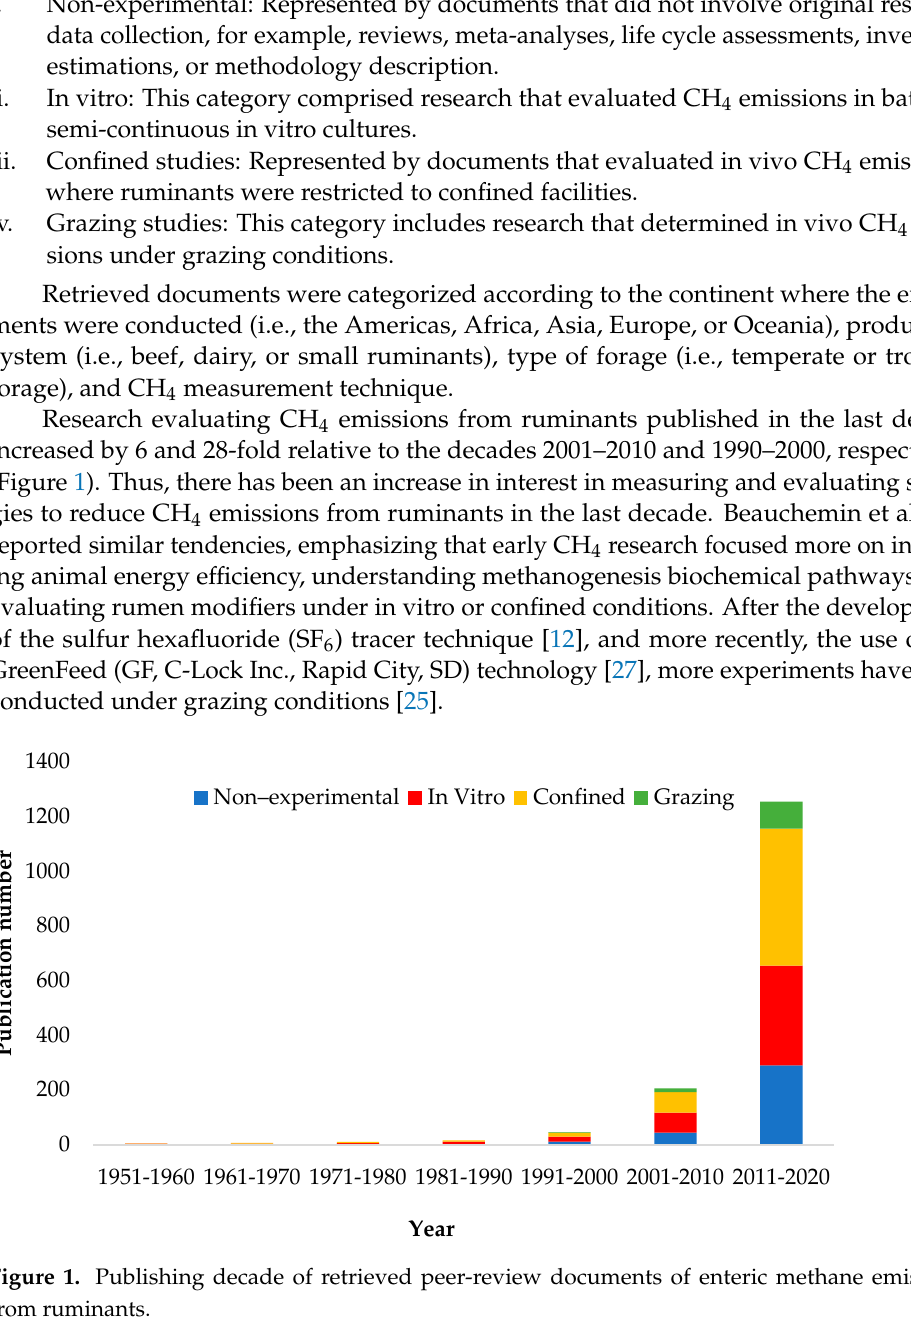
Figure 1. Publishing decade of retrieved peer-review documents of enteric methane emissions from